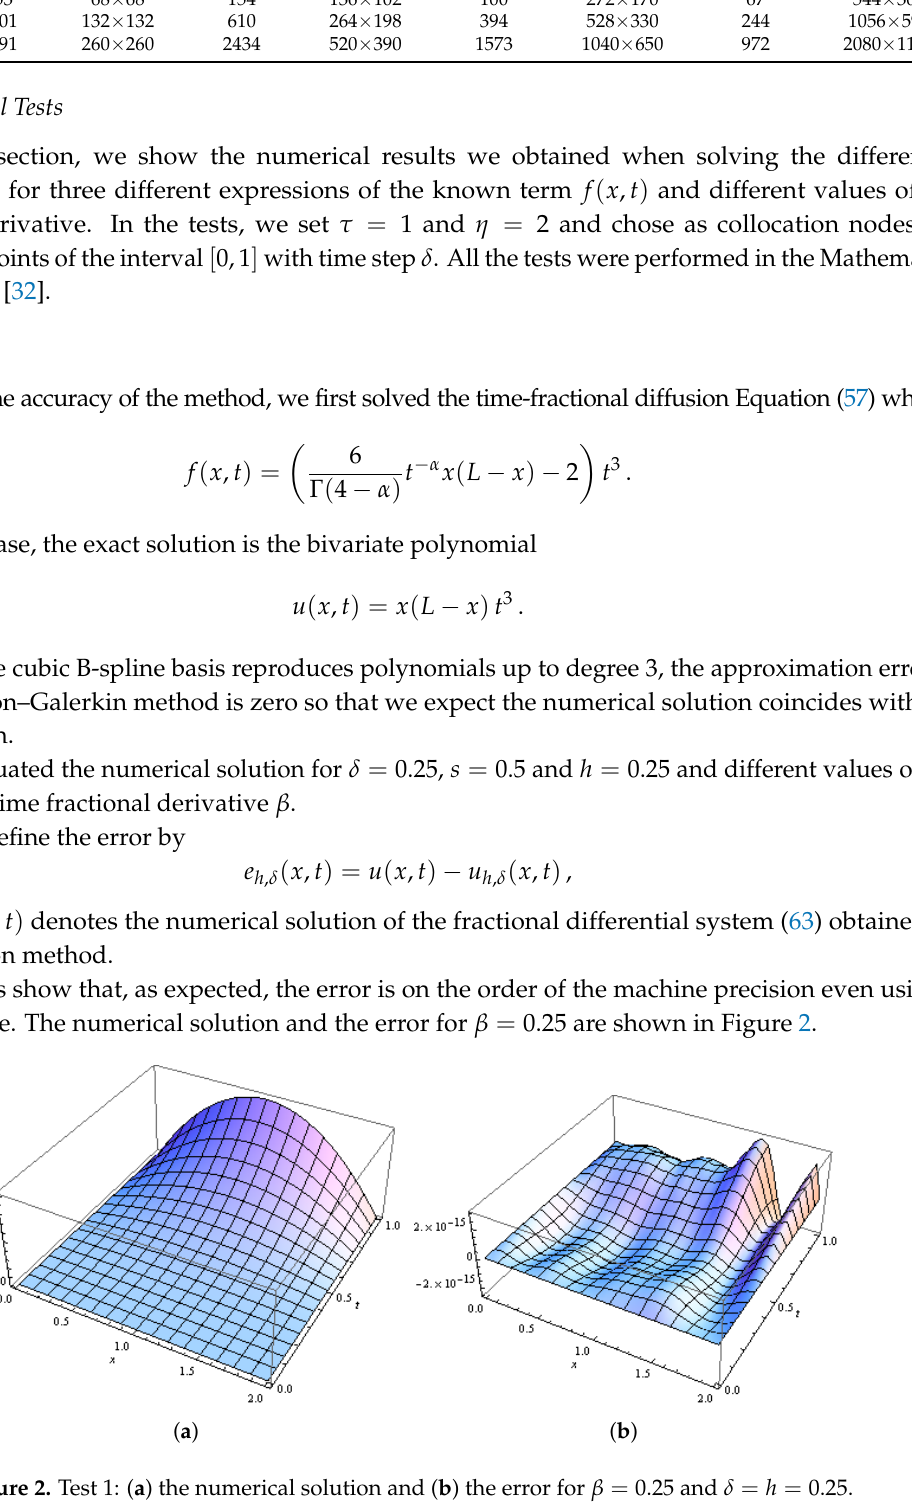
Figure 2. Test 1: ( a ) the numerical solution and ( b ) the error for β = 0.25 and δ = h =